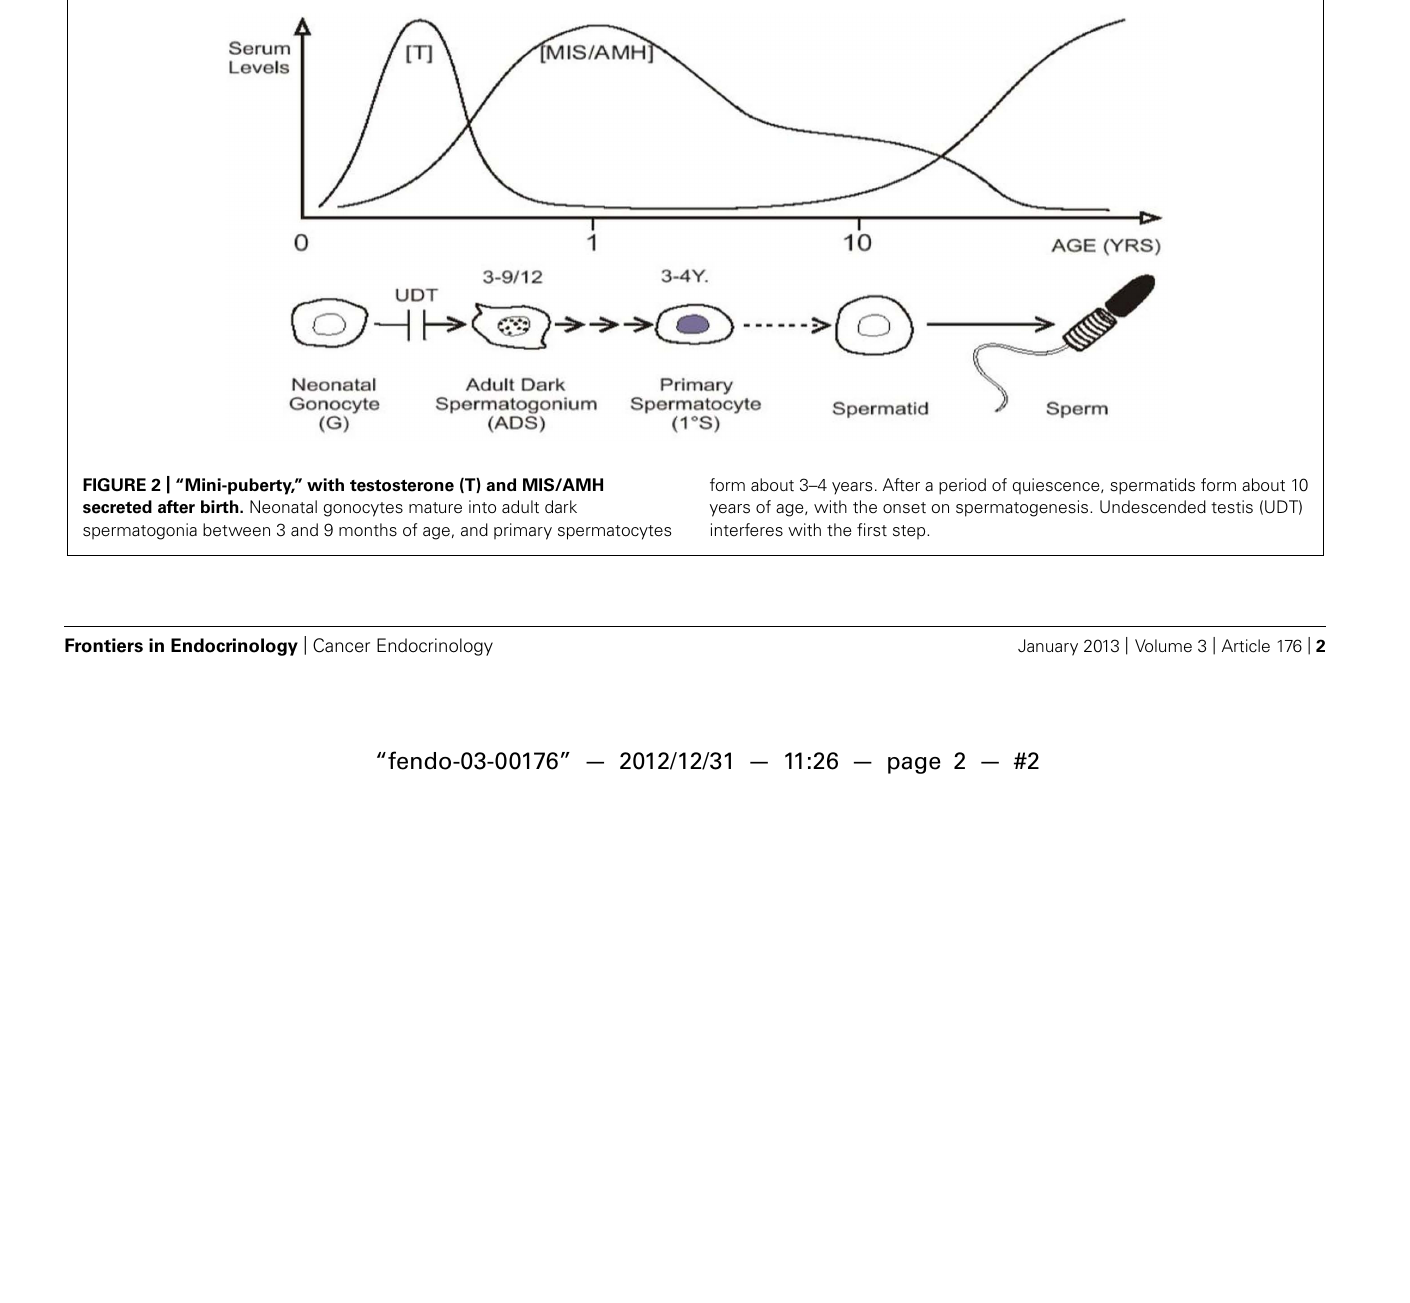
during midgestational growth (8–15 weeks). (C) Calcitonin gene-related peptide (CGRP) released by the genitofemoral nerve, and under the control of testosterone, steers the migrating gubernaculum to the scrotum.